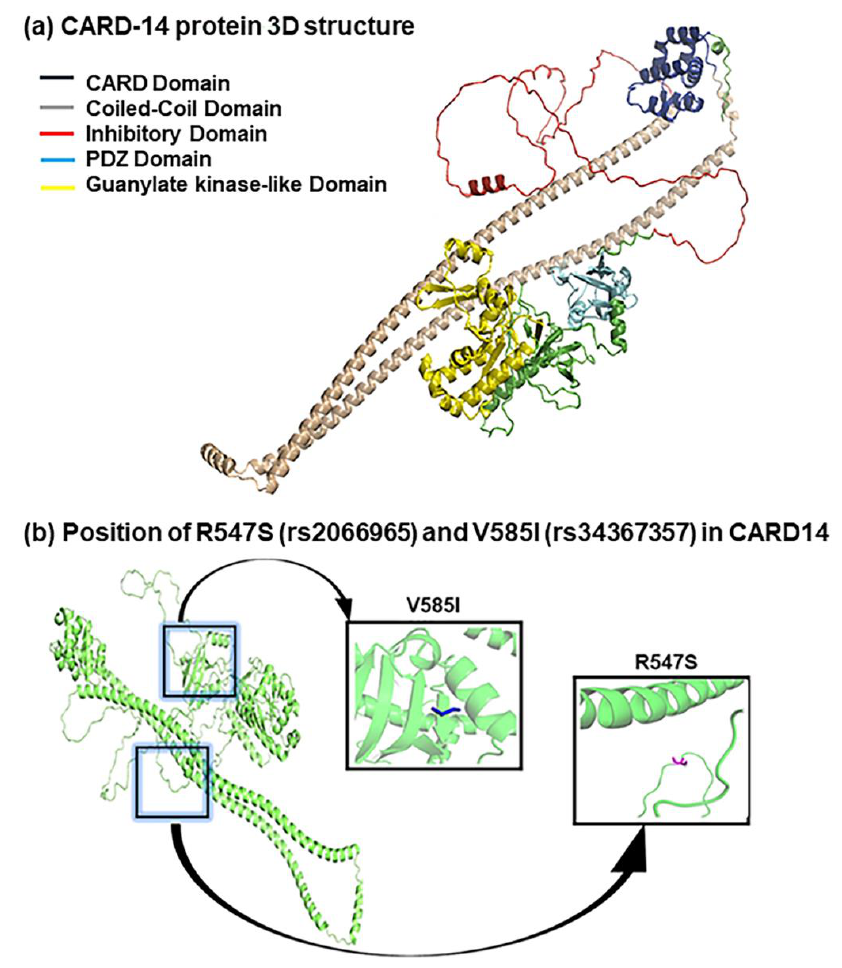
Figure 4. Structural analysis of CARD14 protein. ( a ) CARD14 protein 3D structure predicted using Alpha-Fold2. InterPro predicted five domains in the CARD14 structure, including CARD domain (Blue), coiled-coil domain (Gray), inhibitory domain (Red), PDZ domain (Cyan), and guanlate kinase-like domain (Yellow). ( b ) Position of R547S (rs2066965) and V585I (rs34367357) in CARD14 3D structure. The R547S is located in the inhibitory domain of CARD14, while V585I is present in the PDZ